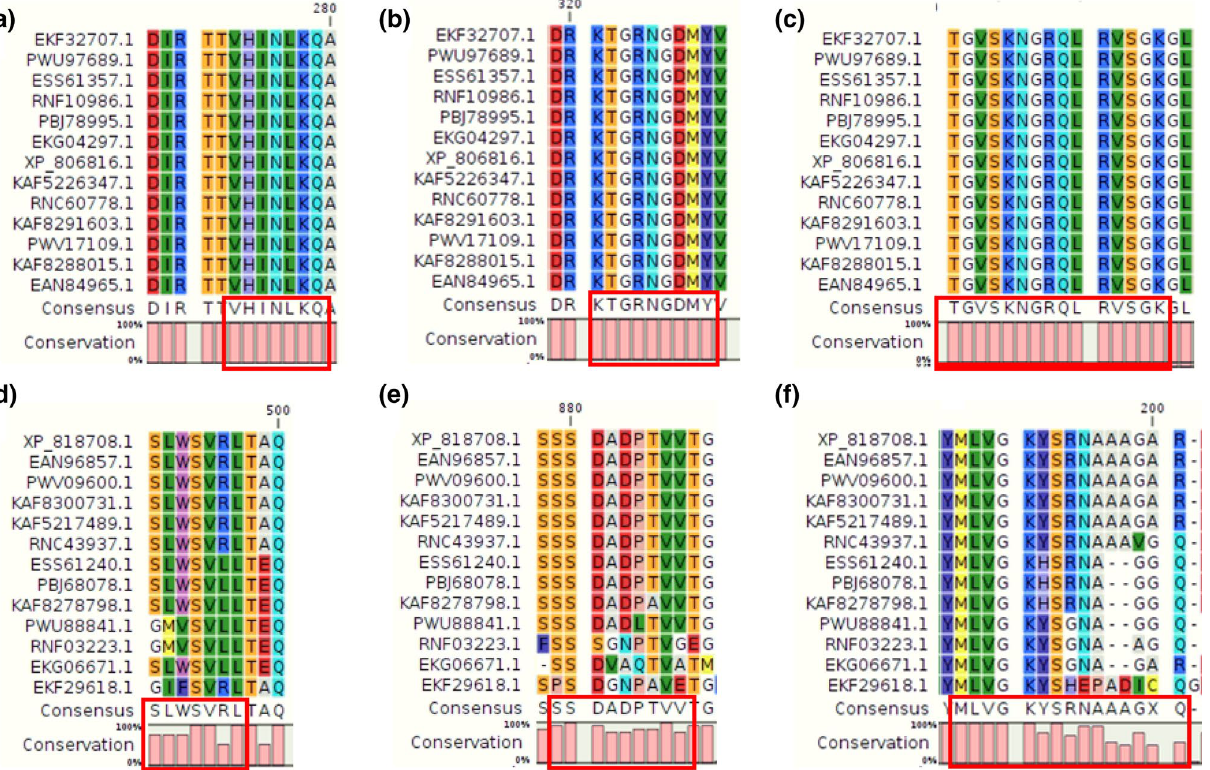
Figure 14. Aligned regions showing conserved epitopes among various strains of T. cruzi . Individual targeted proteins (DNAJ chaperon and trans-sialidase proteins) among the 12 strains are aligned using CLC Main workbench and the regions with conserved epitopes (sequences) have been shown in the red boxes. ( a ) DNAJ BCL epitope; ( b ) DNAJ CTL epitope; ( c ) DNAJ HTL epitope; ( d ) trans-sialidase BCL epitope; ( e ) trans-sialidase CTL epitope; and ( f ) trans-sialidase HTL